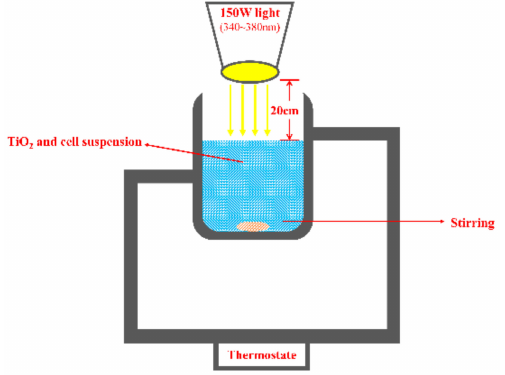
Figure 1. Schematic diagram of the photocatalytic